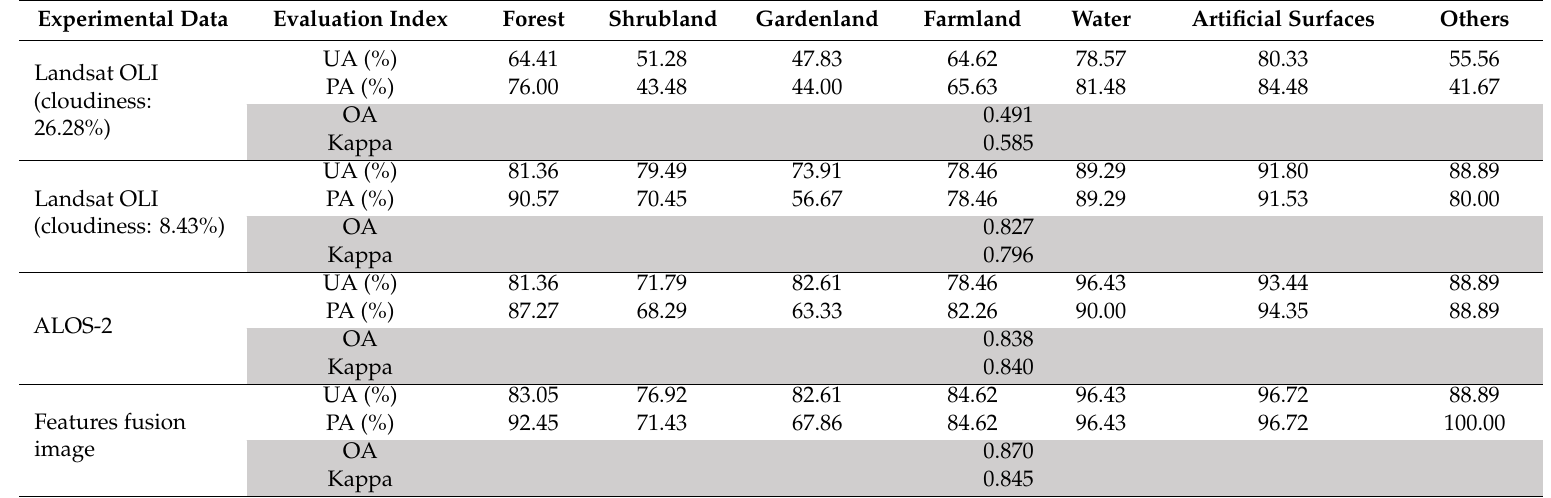
Table 4. Comparison of classification accuracies for di ff erent land